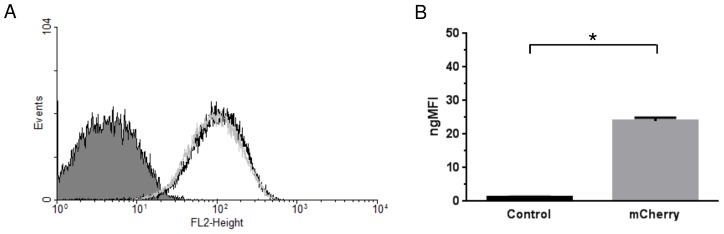
Flow cytometric functional analysis of P. brasiliensis codon-optimized mCherry in P. pastoris.Synthetic codon-optimized mCherry ORF was expressed in a P. pastoris heterologous expression system to certify in vivo functionality after the codon-optimization process. (A). Representative histogram of the red fluorescence intensity (FL2-Height plotted onto 4 decade logarithmic scale versus frequency of Events) of yeast cell population from two distinct recombinant colonies expressing mCherry (light-gray and black peaks) in respect to a negative control yeast cell population transformed with an empty vector (solid dark-gray peak). (B). The geometric mean fluorescence intensity (gMFI) of two positive yeast cell colonies was normalized (ngMFI) in respect to two negative yeast cell colonies and plotted as a bar graph (*, P<0.0001).